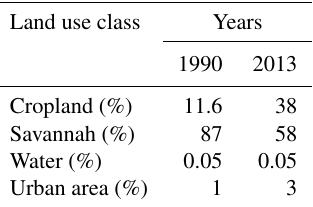
Table 1. Percentage of the catchment area per land use class in 1990 and